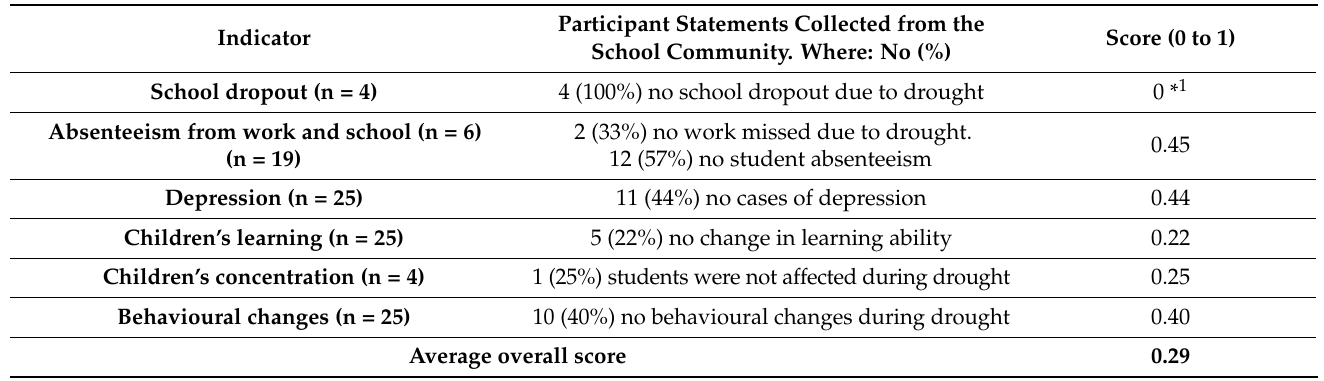
Table 8. Results of the survey carried out for the mental well-being Dimension and its indicators. Weighting was 3; where n = total number of